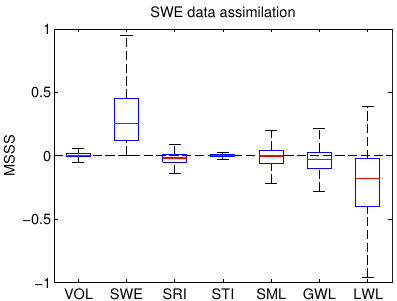
Figure 7. Box plot of the mean square skill score for each variable when assimilating SWE from all three snow pillow locations. The open loop is used as a reference. Outliers are not shown for visibility purposes.